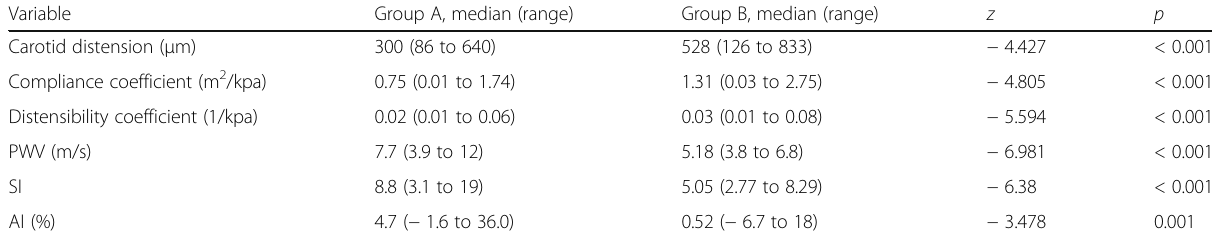
Table 2 Carotid quality arterial stiffness parameters in SLE patients (group A) and controls (group B) Variable